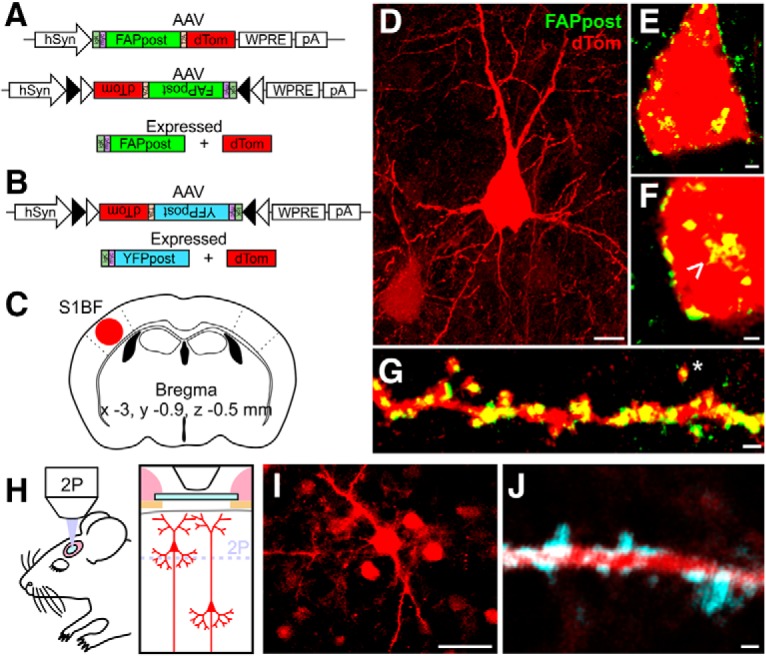

Construct design and expression in mouse somatosensory (S1BF) cortex. A, FAPpost construct design. Human synapsin promotor (hSyn) driving either a constitutively-expressed or Cre-dependent (Fl) FAPpost and dTom, separated by a 2A sequence for independent localization. B, Fl-YFPpost construct. Cre-dependent YFPpost and dTom expression. C, Virus injection coordinates. D, Confocal image stack of L2/3 Pyr cell transfected with FAPpost. Scale bar = 10 μm. E, Optical section of FAPpost puncta on soma of cell in D. Scale bar = 2 μm. F, Zoom of E. Arrowhead marks cytoplasmic FAPpost accumulation. Scale bar = 1 μm. G, FAPpost-labeled spiny dendrites. Scale bar = 1 μm. H, In vivo 2P imaging schematic. I, Single-plane 2P image of L2 Pyr cells transfected with of YFPpost and dTom. Scale bar = 30 μm. J, Single-plane 2P image of YFPpost-labeled spiny dendrite in L1. Scale bar as in G. See also Movie 1.